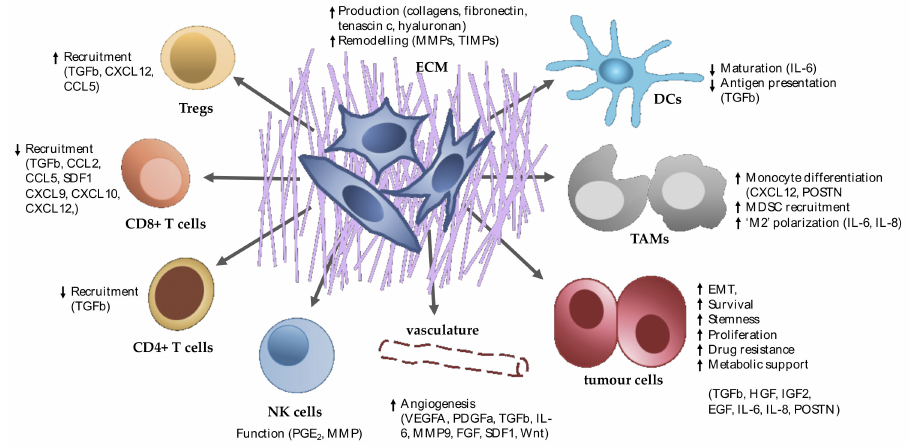
Figure 1. Paracrine CAF signalling influences multiple cell types in the